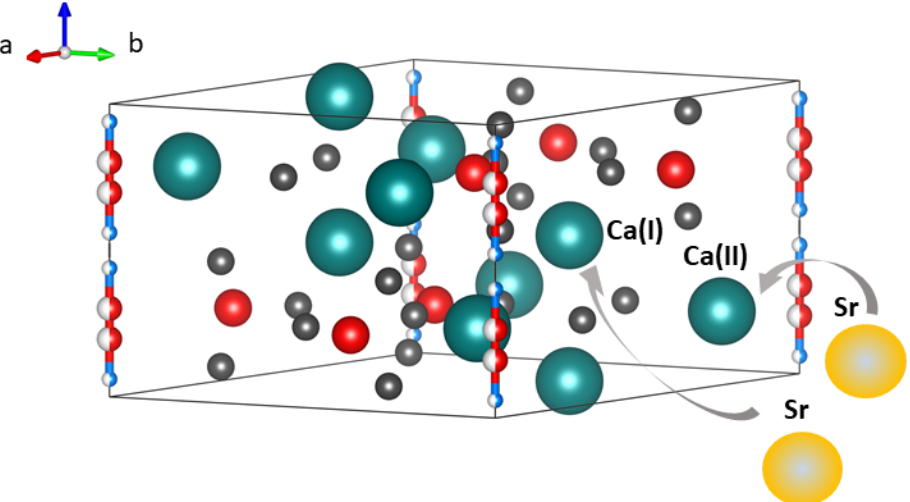
Figure 4. Incorporation of strontium ions into the structure of calcium hydroxyapatite (a-, b- and c-axes orientation).